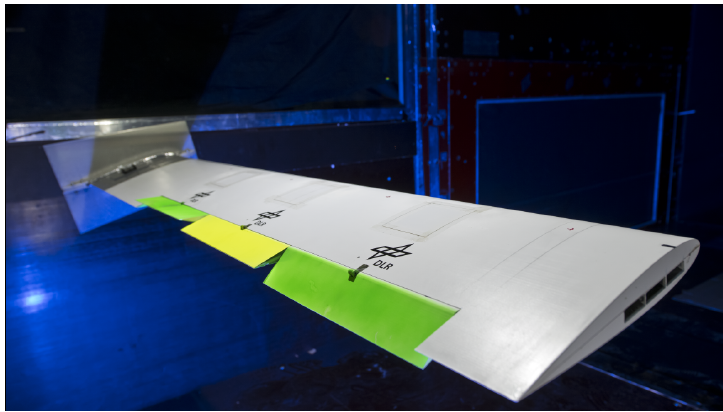
Figure 2. Wing mounted to pitch motor at the wing root in the wind